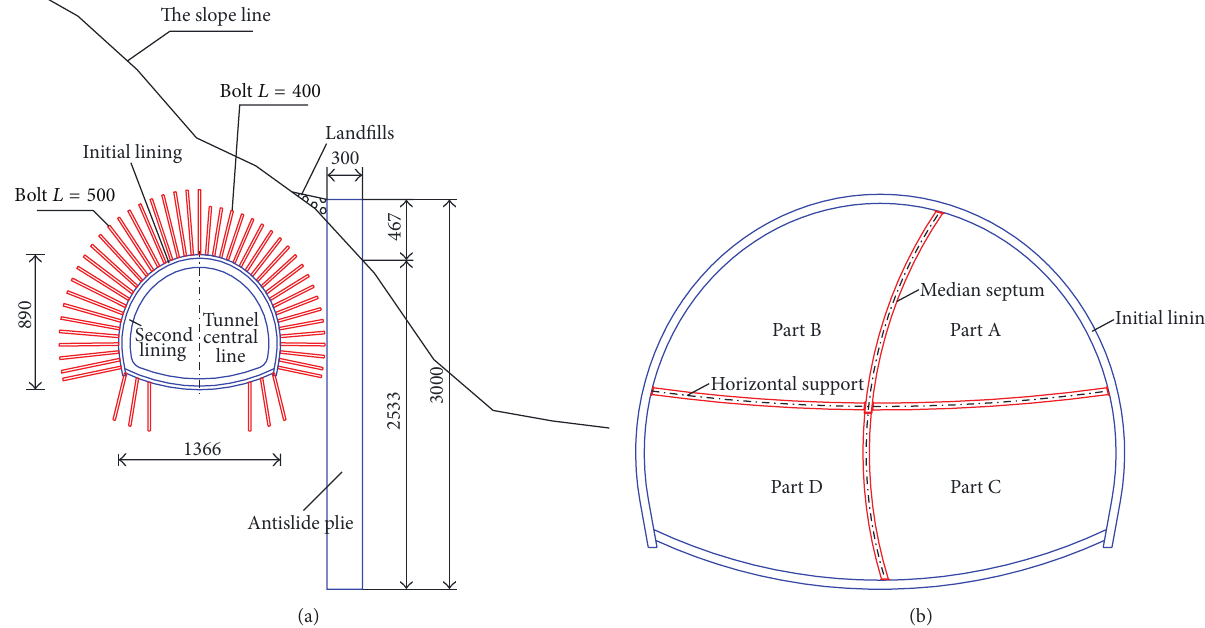
Figure 10: The support system and excavation sequence: (a) support system at ZK49+899; (b) excavation sequence with CRD method (length unit: